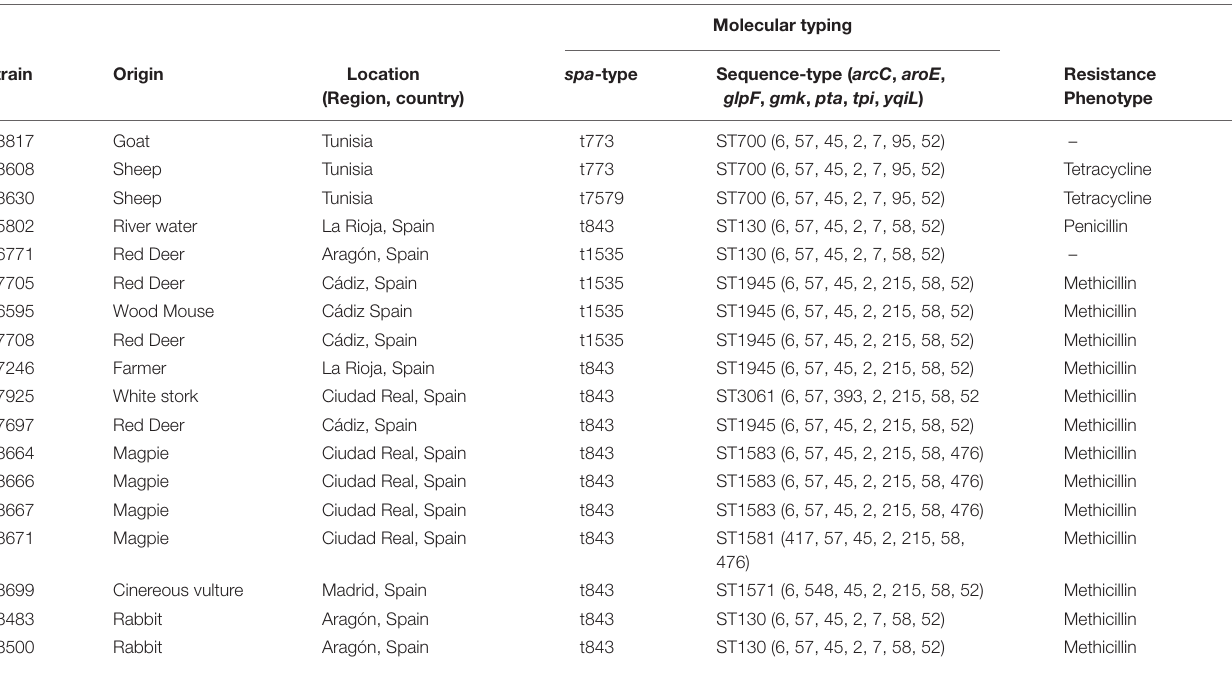
TABLE 1 | Characteristics of the 18 S. aureus CC130 strains (13 MRSA and 5